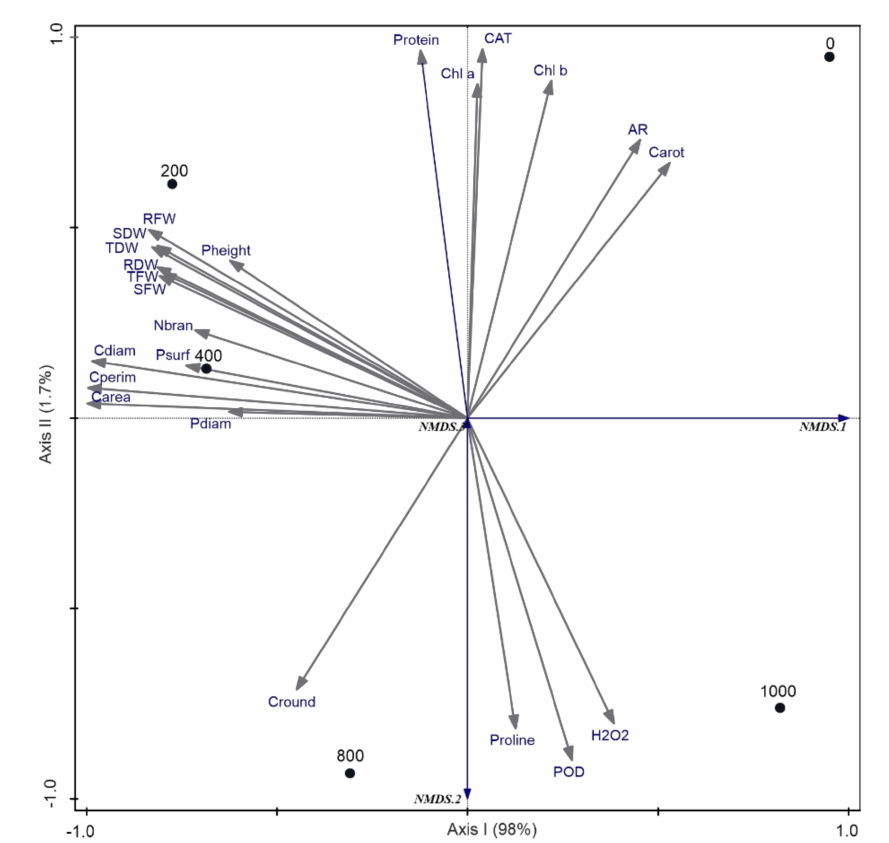
Figure 8. Non-metric multidimentional scaling (NMDS) results—comparison between treatments based on Bray-Curtis dissimilarity measure. Plant functional traits projected as